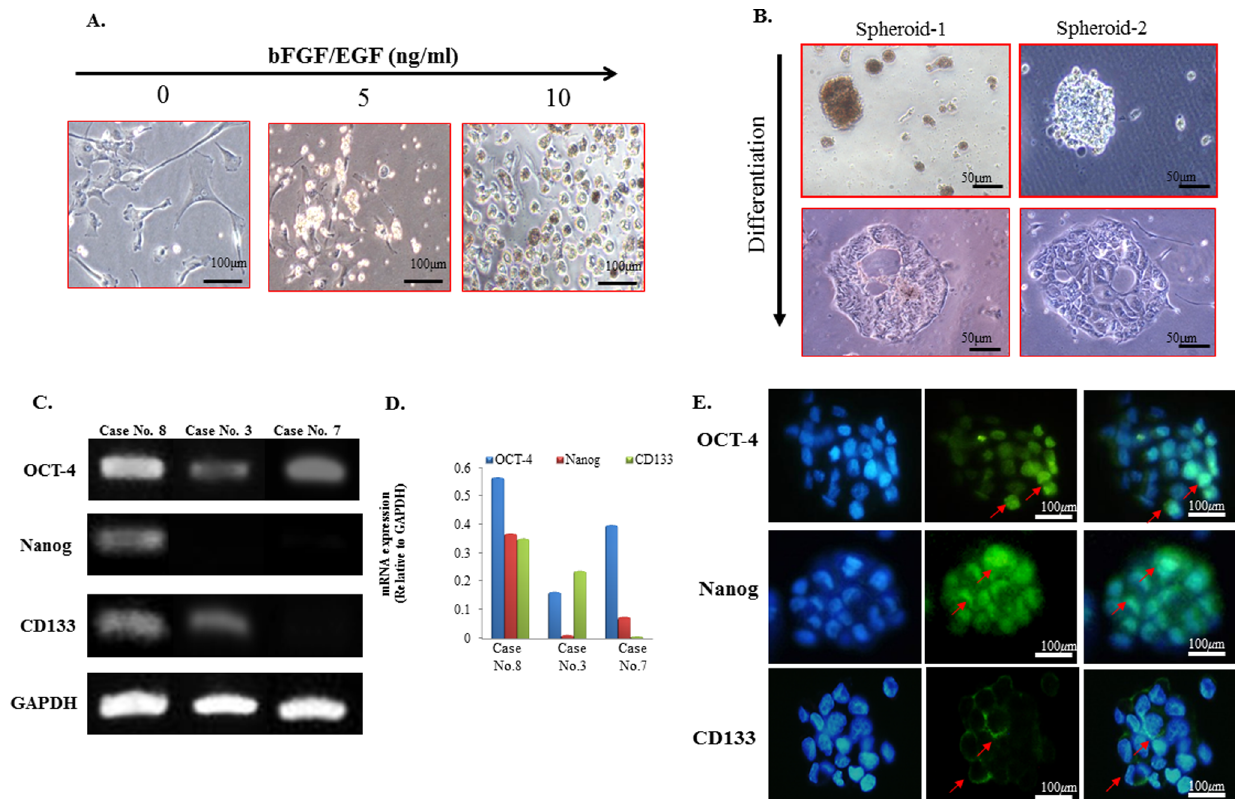
the expression of OCT-4 also significantly related to distant metastasis ( p = 0.0121) and stage ( p , 0.0001). The Kaplan-Meier analysis demonstrated the expression of OCT-4 was inversely associated with survival in patients with MPE after a long term follow-up.